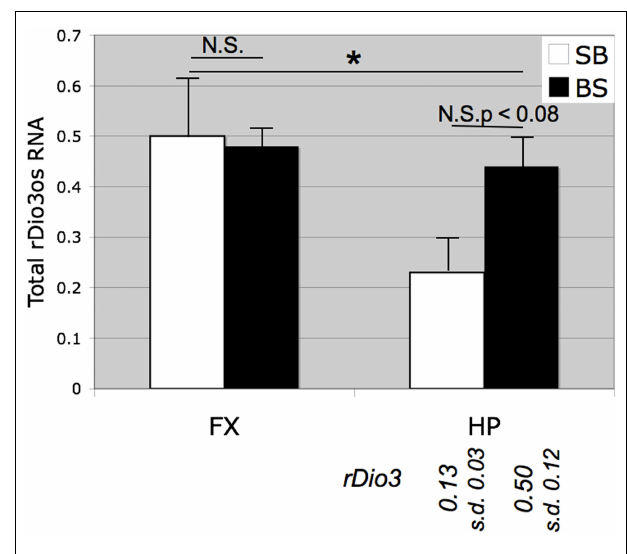
FIGURE 2 |Allele-specific expression analysis demonstrates that rDio3os expression is imprinted in a strain, region, and developmental- specific manner paralleling that of rDio3 . Here, various imprinted expression patterns are shown for fetal and adult male hippocampus (HP) and frontal cortex (FX), respectively. rDio3 imprinted expression is reproduced from our previous work (Sittig etal., 2011a). Relative rDio3os expression across a SNP between Sprague-Dawley (SD;T allele) and Brown-Norway (BN; A allele) animals was determined following (a)